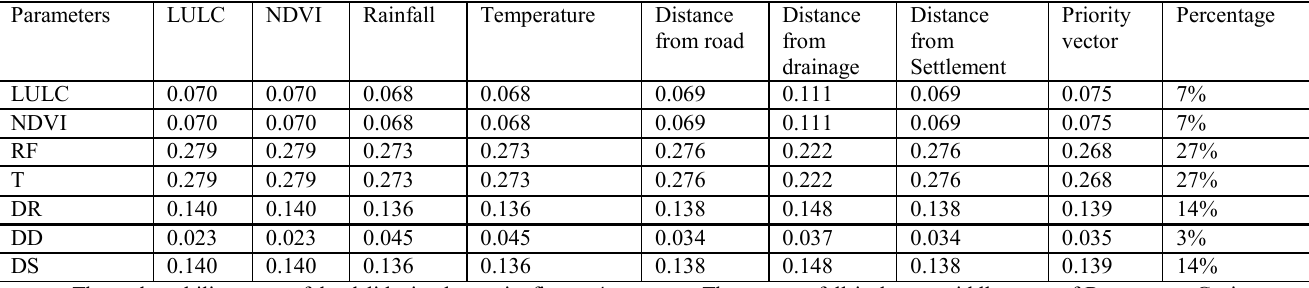
The vulnerability map of landslide is shown in figure